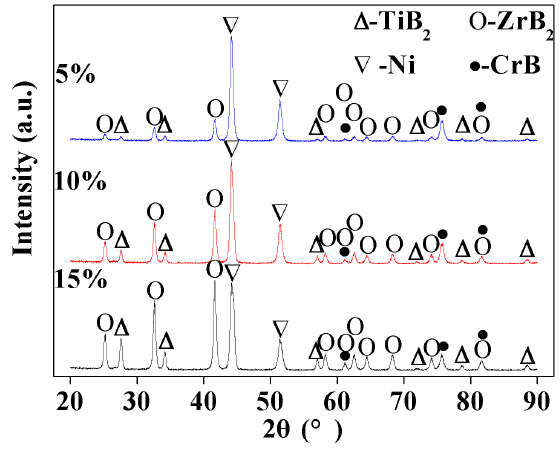
Figure 1. X-ray diffraction (XRD) spectra of three kinds of NiCr–TiB 2 –ZrB 2 powders.